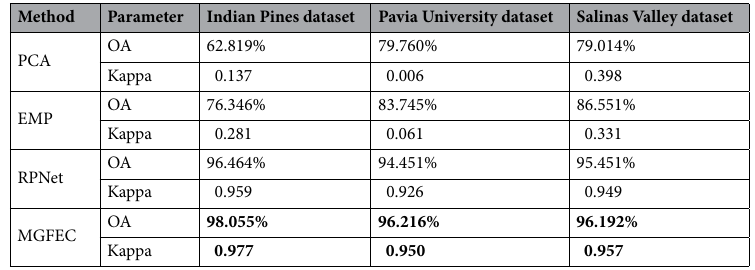
Table 5. OA value and Kappa coefficient value of different methods in different